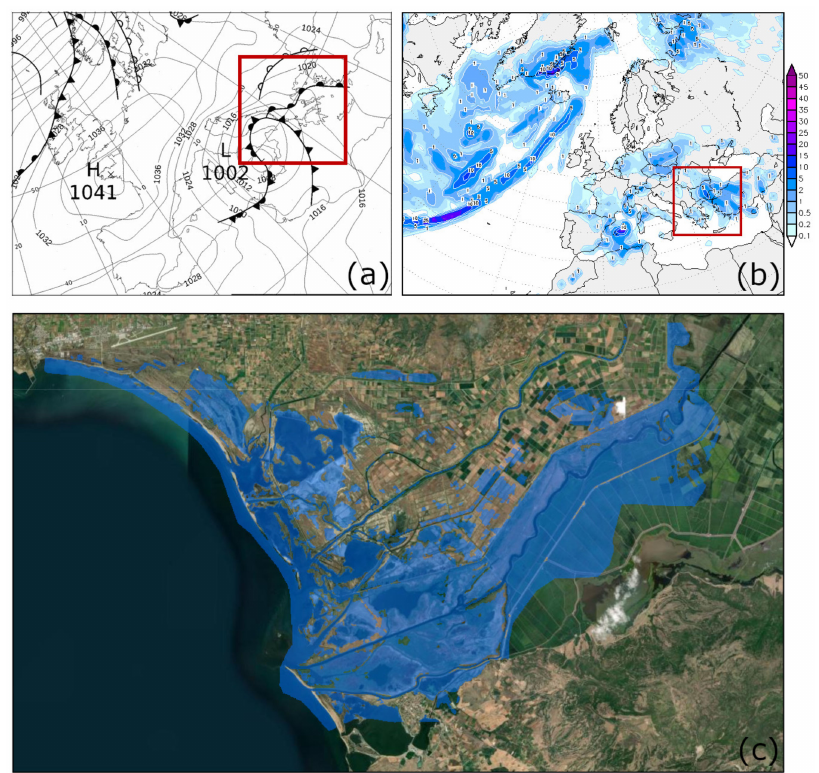
Figure A6. As in Figure A1, but for the second 2015 flood event.